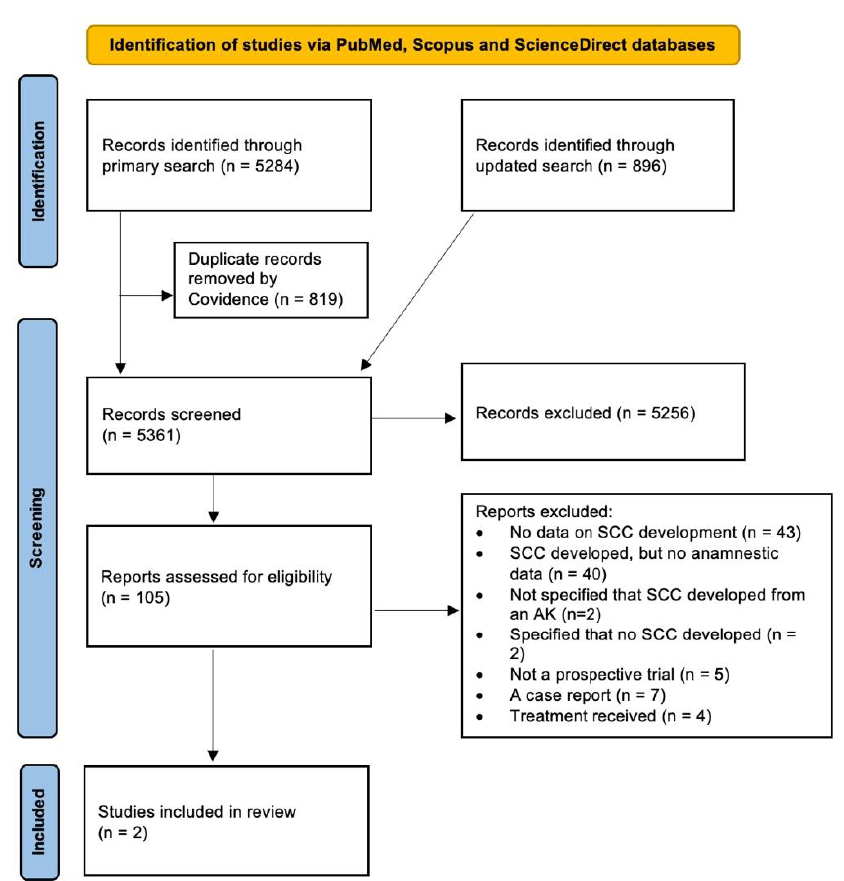
Figure 1. PRISMA flow diagram of the article selection process. Two studies met the inclusion criteria. AK—actinic keratosis. SCC—squamous cell carcinoma.